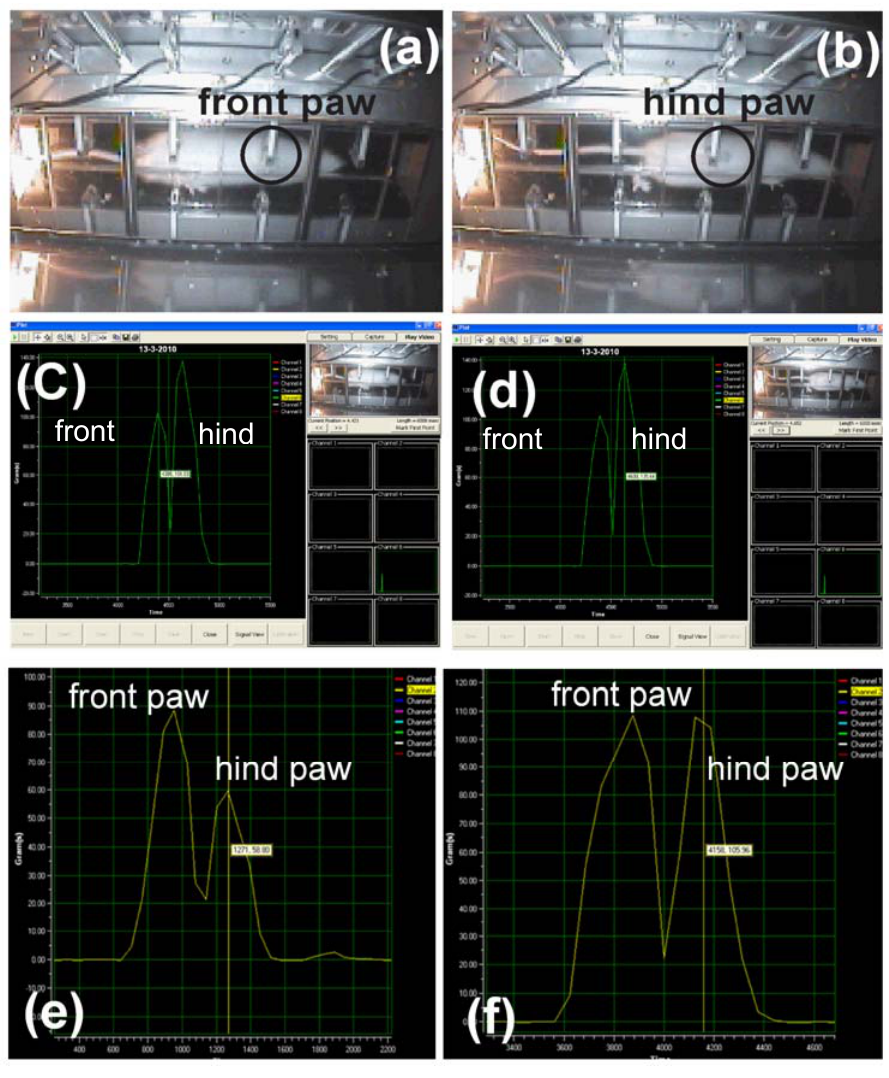
Figure 1. Walking steps of rat were captured by CCD camera, ( a ) and ( b ) showed the image of front and hind paws. Typical stepping force versus time curves constructed and for normal hind and front paws before the induction of arthritis ( c , d ), after the induction of arthritis by FCA injection ( e ) and in the FCA-induced arthritic rats treated with prednisolone ( f ). In normal rats, the stepping force produced by the hind paw was always higher than that of the front paw (c,d). After the induction of arthritis, the stepping force produced by the affected hind paw decreased (e). There was an improvement in the stepping force in rats treated with prednisolone (f).